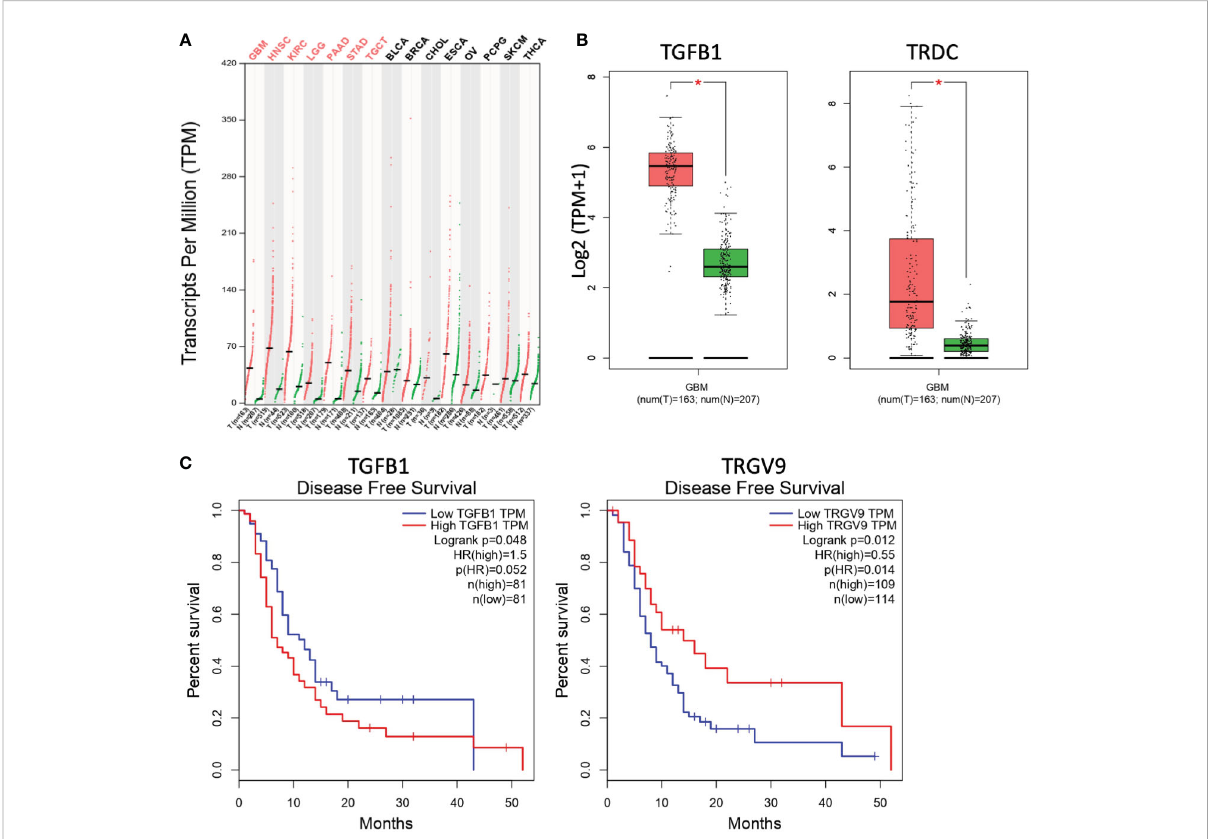
FIGURE 1 Levels of TGF- b and gd TCR transcripts are differently linked to the prognosis of glioblastoma tumors. (A) The abundance of human TGF- b transcripts (TPM, transcripts per million ) across various indicated cancers ( T, red ) and the normal tissues associated ( N, green ) was analyzed and compared by matching TCGA and GTEx data. GBM, glioblastoma multiforme; HNSC, head and neck squamous cell carcinoma; KIRC, kidney renal clear cell carcinoma; LGG, brain lower grade glioma; PAAD, pancreatic adenocarcinoma; STAD, stomach adenocarcinoma; TGCT, testicular germ cell tumors; BLCA, bladder urothelial carcinoma; BRCA, breast invasive carcinoma; CHOL, cholangiocarcinoma; ESCA, esophageal carcinoma; OV, ovarian serous cystadenocarcinoma; PCPG, pheochromocytoma and paraganglioma; SKCM, skin cutaneous melanoma; THCA, thyroid carcinoma. Red abbreviations , tumors with signi fi cantly increased TGF- b transcripts, as compared to normal tissues. n , number of clinical samples. (B) Comparative analyses of transcript levels [Log2 (TPM+1)] of TGF- b 1 (TGFB1, left ) and TCR d chain (TRDC, right ) in GBM tumors ( red ) vs normal tissues associated ( green ). *p<0.05. (C) Compared disease-free survival curves for GBM patients with high ( red ) vs low ( blue ) levels of transcripts of TGF- b 1 ( left ; TGFB1; cutoff-high 50%) or TCR V g 9 chain ( right; TRGV9; cutoff-high 25%). Data from